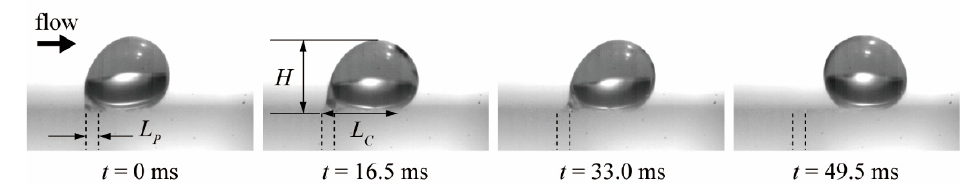
Figure 3. Representative image sequence of the pinned droplet starting to run downstream. The air velocity in this case was U ∞ = 8 m / s. At 16.5ms, the droplet was just released from pinning through the pore. The droplet dimensions was measured in this phase. The height of droplet, H , is defined as the length from the coating surface to the top of the droplet image. The contact length, L C , is also defined as the width of the contact area.